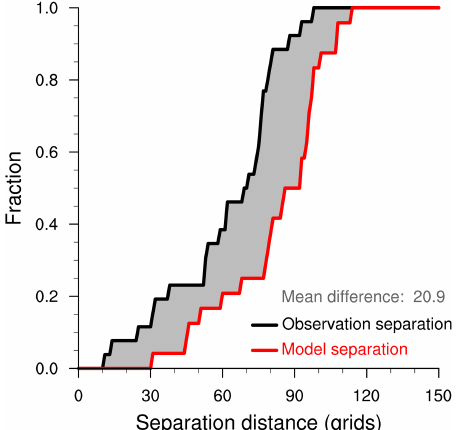
Figure 3. Cumulative distributions of the separation (ice edge dis- placement) distances from t 0 to t 0 + (cid:49)t for model results (red curve) and observations (black curve). Shown here are results for the ide- alized example displayed in Fig. 1, with distances subsampled at intervals of the decorrelation lengths, which are 42 and 38 grid cells along the ice edge for the model results and observations, respec- tively. The mean separation distance difference for the present sub- sample of ice edge grid cells is the integral of the area between the curves, here displayed by gray shading. In this case, the mean dif- ference is 20.9 in grid cell units with larger displacement values in model results than from